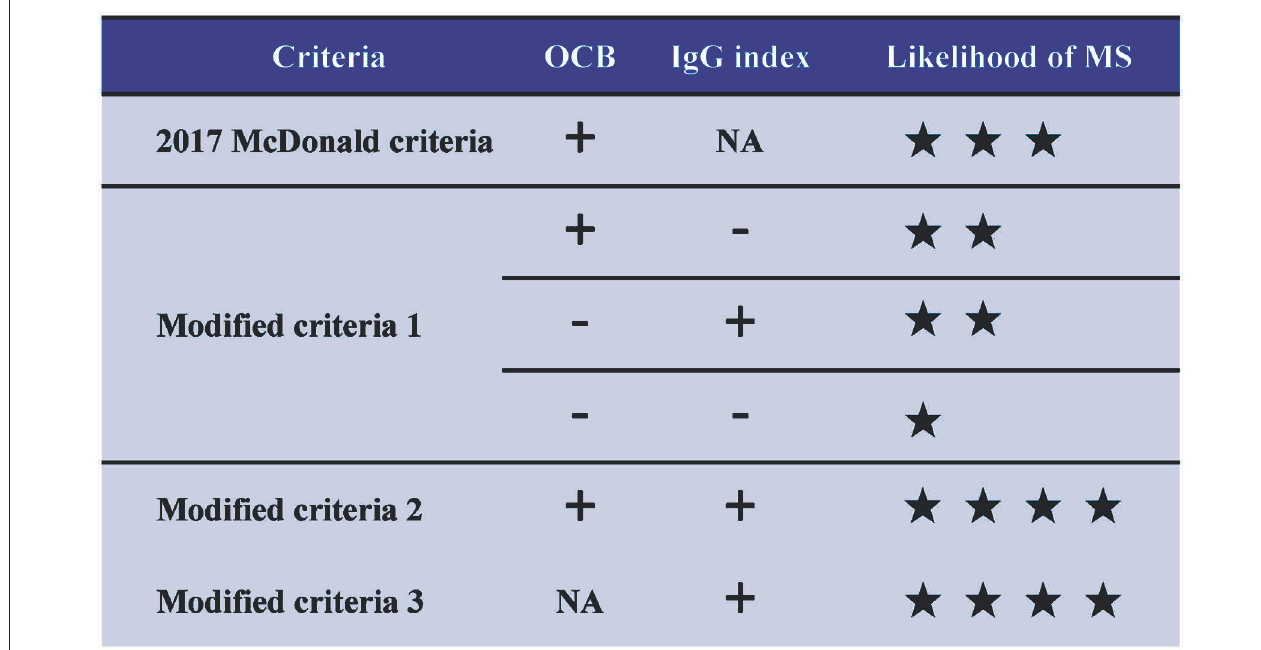
FIGURE 2 | The likelihood of multiple sclerosis diagnosis based on OCB status and/or IgG index positivity in the 2017 McDonald criteria. When compared to the 2017 McDonald criteria (PLR 1.54, NLR 0.56), the modified criteria 2 (IgG index and OCB) and modified criteira 3 (IgG index) displayed a higher PLR (both 2.11) yet a higher NLR (0.71 and 0.58, respectively). The modified criteria 1 (IgG index or OCB) displayed a lower NLR (0.53) yet a lower PLR (1.44). IgG, Immunoglobulin G; OCB, oligoclonal band; PLR, Positive likelihood ratio; NLR, Negative likelihood